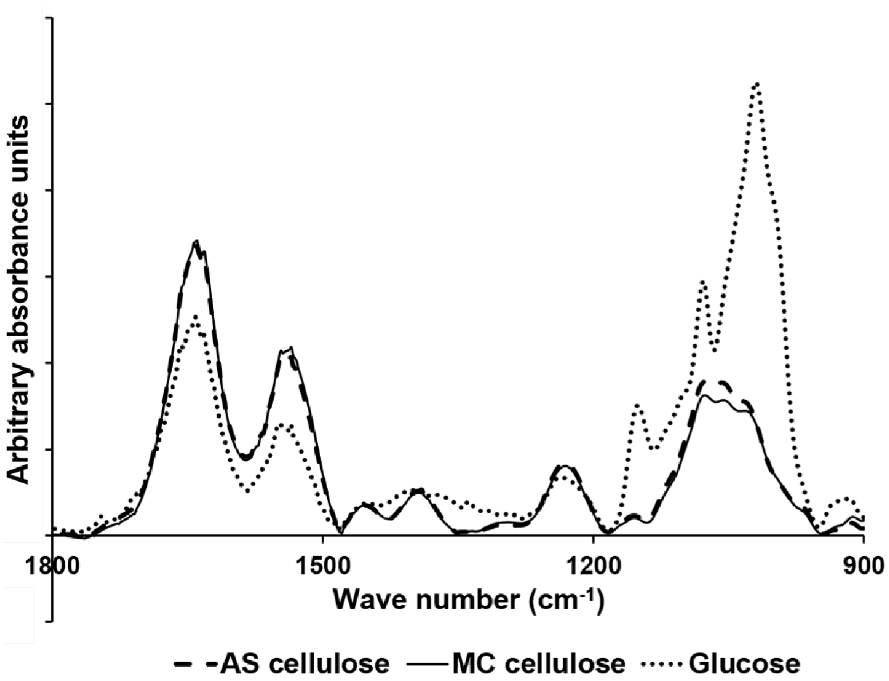
Fig 4. Comparative FTIR spectrum of F . succinogenes S85 strains grown under different carbon substrate conditions.